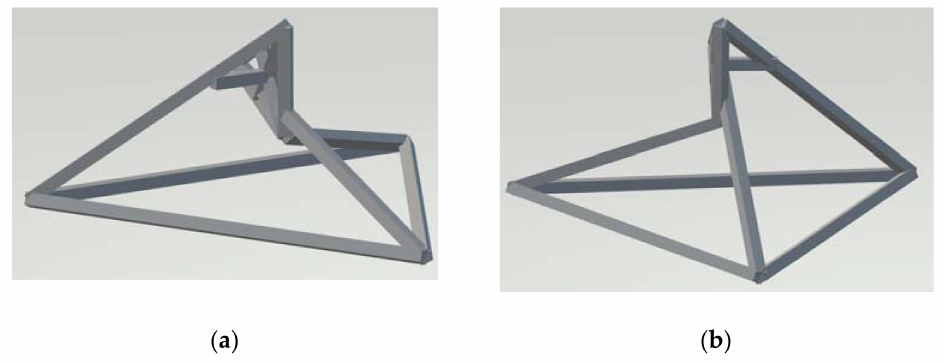
Figure 7. Examples of link intersections for the range of angles θ and ψ ± 95 ◦ —( a ) intersection of links OO (cid:48) and D 3 E 3 , D 1 D 2 and E 2 E 3 , ( b ) intersection of links OO (cid:48) and D 2 E 2 , D 1 D 2 and E 2 E 3 .